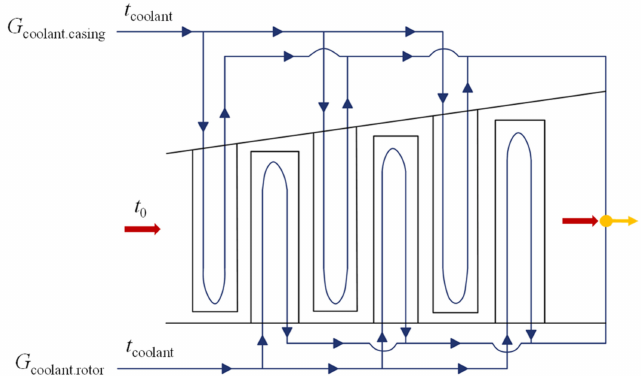
Figure 6. Analysis chart of a steam turbine cooled